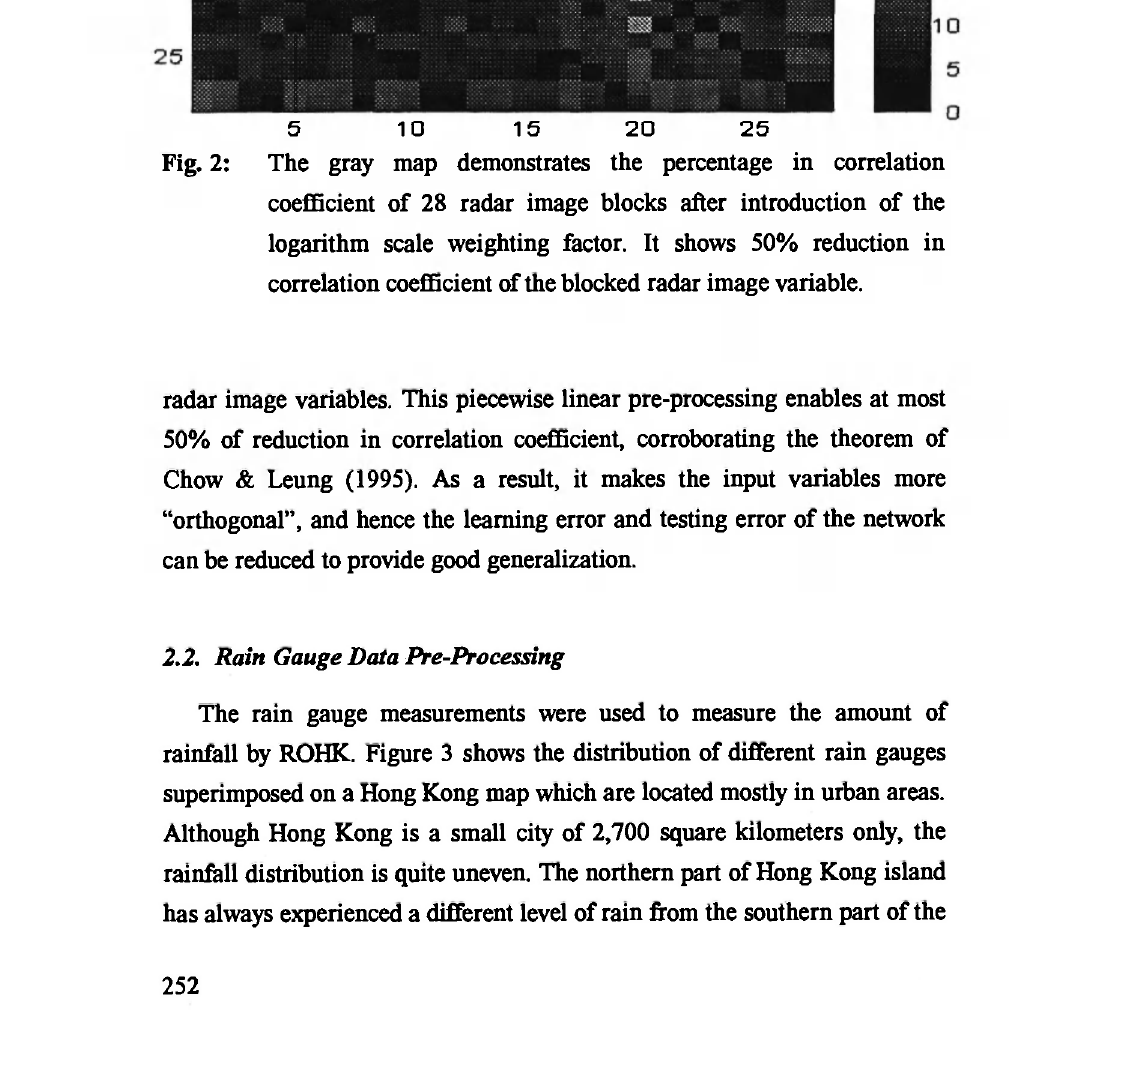
Fig. 2: The gray map demonstrates the percentage in correlation coefficient of 28 radar image blocks after introduction of the logarithm scale weighting factor. It shows 50% reduction in correlation coefficient of the blocked radar image